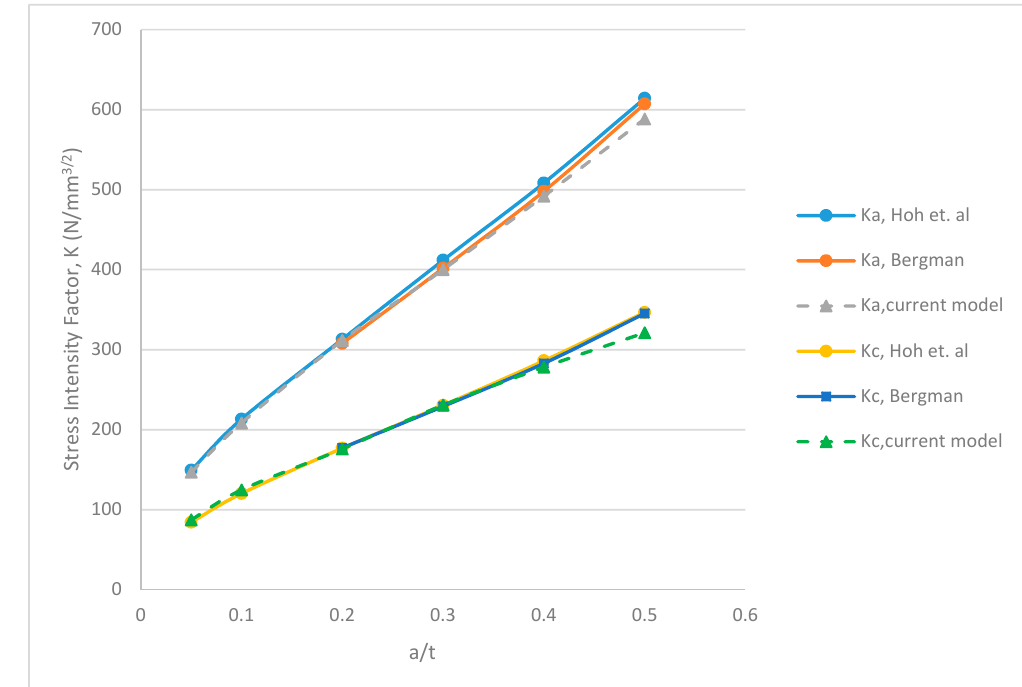
Figure 15 . Comparison of SIFs at the deepest point ( K a ) and surface point ( K c ) for semi-elliptical surface cracks in plain pipe under tension for a/c = 0.25.